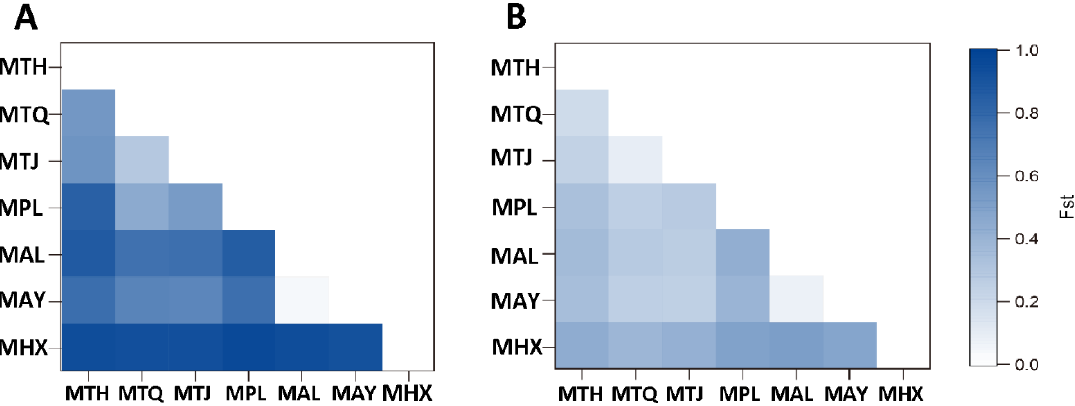
Figure 5. Heat map of pairwise F st comparing between 7 populations of Megalobrama fish according to mtDNA ( A ) and SRAP ( B ) marker data. All estimates were significantly different from zero at the p < 0.05 level. MTH, M. terminalis in the Heilong River; MTQ, M. terminalis in the Qiantang River; MTJ, M. terminalis in the Jinsha River Reservoir; MPL, M. pellegrini in the Longxi River; MAL, M. amblycephala in the Liangzi Lake; MAY, M. amblycephala in the Yi River and MHX, M. hoffmanni in the